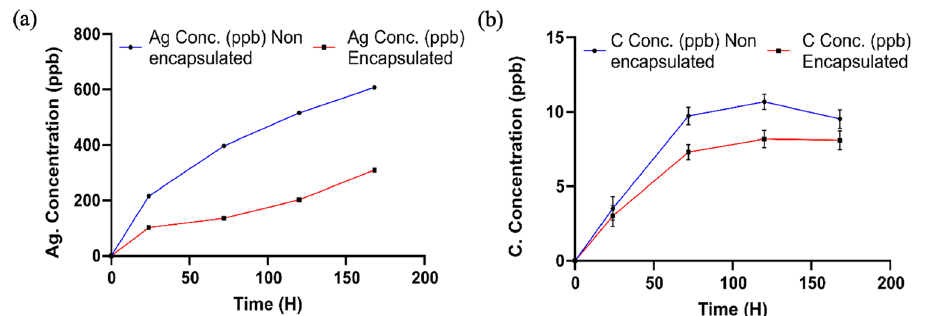
Figure 2. Quantitation of time-dependent leaching of ( a ) Silver (Ag + ) ions, ( b ) Carbon atoms from the non- encapsulated (blue line) and encapsulated (red line) sensors at varying time points (1, 3, 5, and 7 days) using ICP-MS. The x-axis represents the time (H) and the y-axis represents the concentration of ions leached (ppb). All the data is depicted as mean ± SD from n = 3 independent